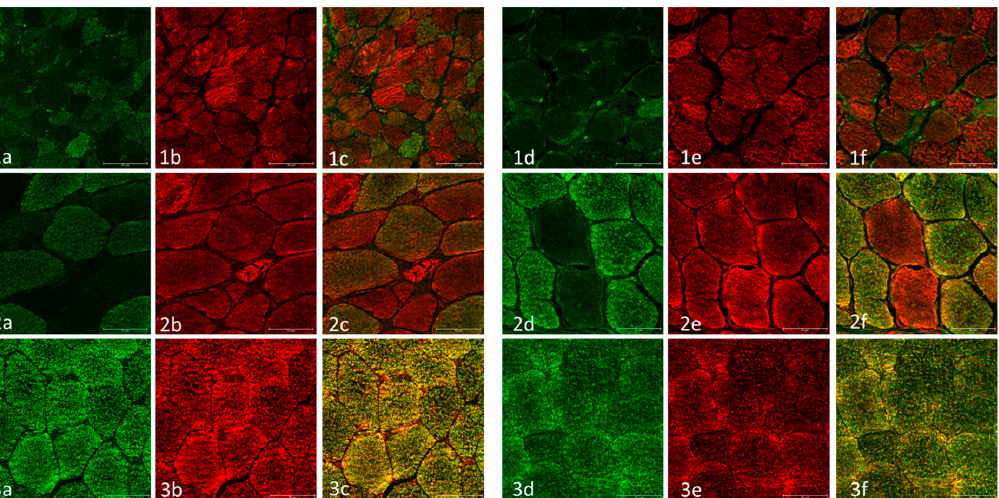
Figure 3. Muscular biopsy from patients with infantile-onset (row 1, corresponding to case 1), childhood-onset (row 2, corresponding to case 8), and a healthy control (row 3). Columns: ( a ) mito- chondrial complex I immunofluorescence stain; ( b ) mitochondrial porin immunofluorescence stain (surrogate for mitochondrial mass); ( c ) merge (mitochondrial co-localization); ( d ) mitochondrial complex IV immunofluorescence stain; ( e ) mitochondrial porin immunofluorescence stain; and ( f ) mi- tochondrial co-localization. In the patient with infantile-onset, a severe deficiency of CI and CIV are shown in almost all the muscular fibres. Red fibres are present in the co-localization images, indicating a deficiency in mitochondrial complexes. In the childhood-onset case, a decrease in staining intensity are observed with the presence of some negative fibres, which are labelled in red in the co-localization image. In the healthy control, the mitochondrial complexes and porin have normal expression and the co-localization is coloured yellow, showing a correct co-expression of both proteins. Scale bar: 50 µ m.